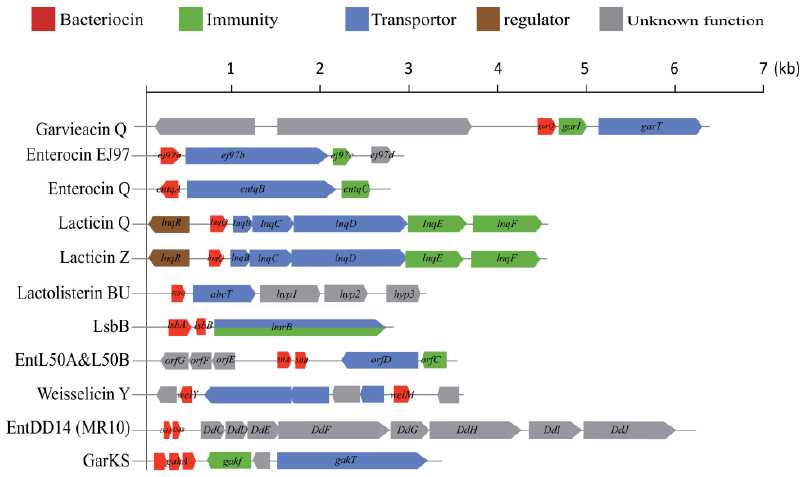
Figure 6. Organization of biosynthetic gene clusters of class IId bacteriocins of LAB.